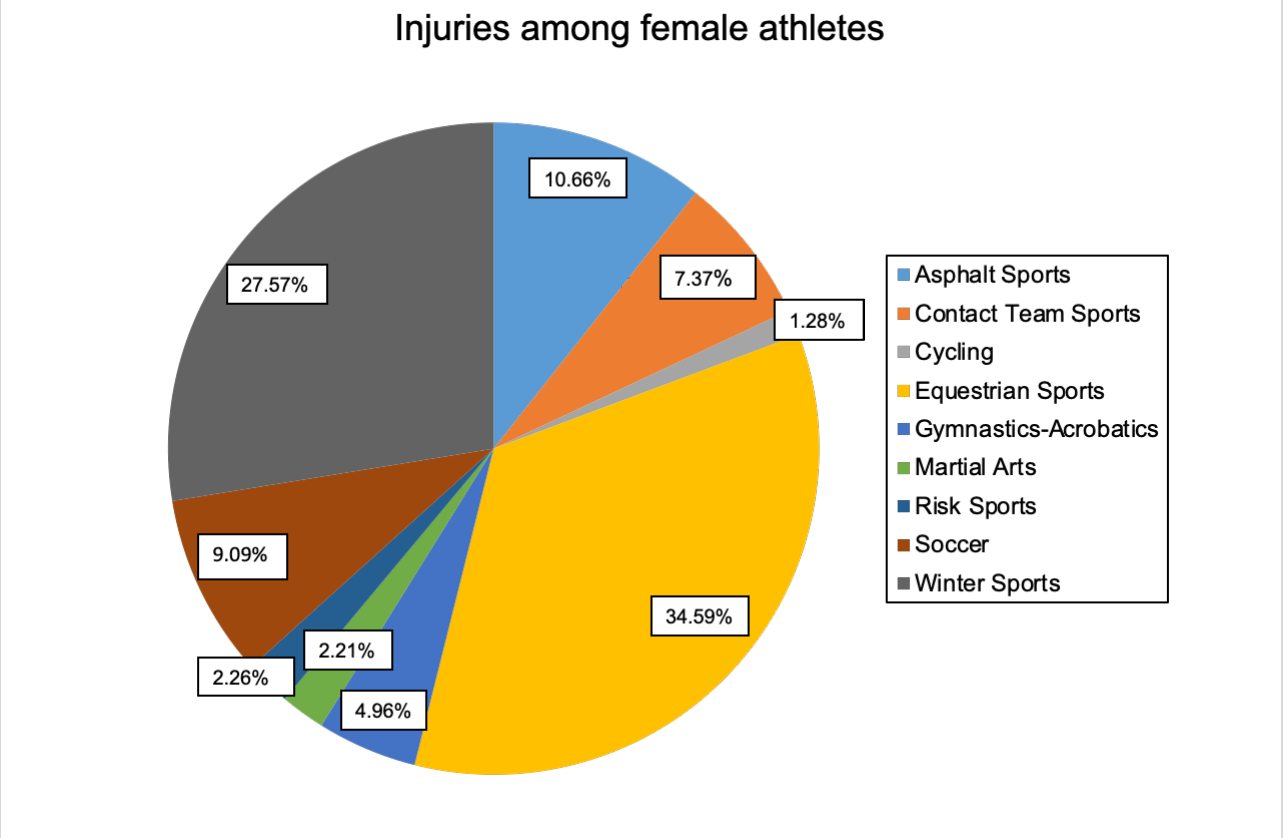
Figure 3. Distribution of injuries among the sports studied (female athletes).